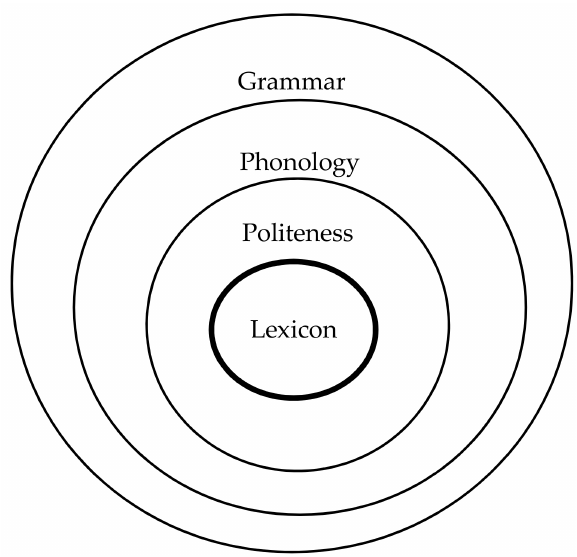
Figure 4. Process of linguistic accommodation (Sancho Pascual 2014, p.